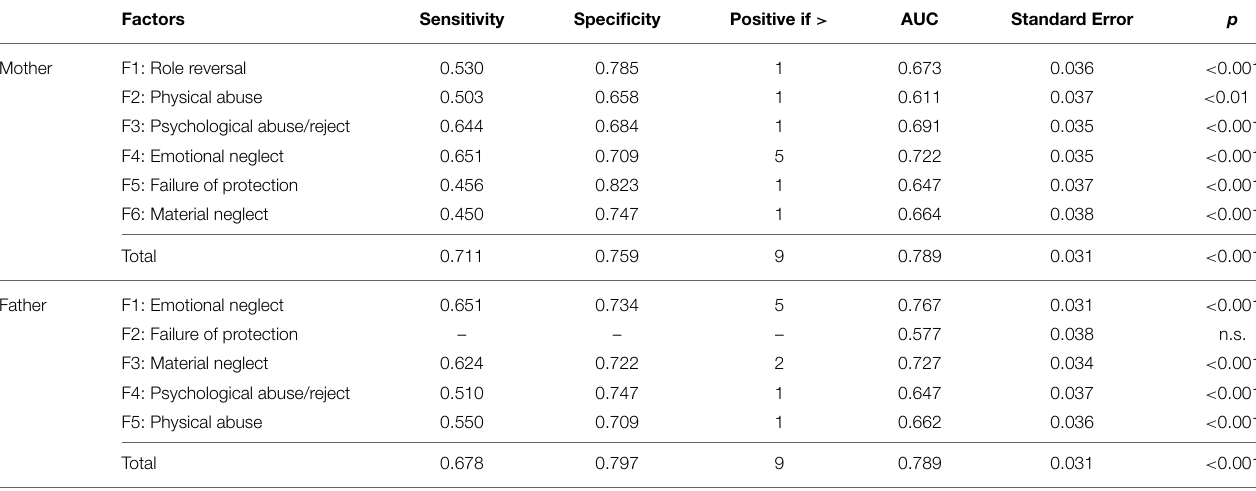
TABLE 3 | Analysis of ROC curves to assess diagnostic accuracy for ComplexTQ factor-derived scales and total scores. Factors